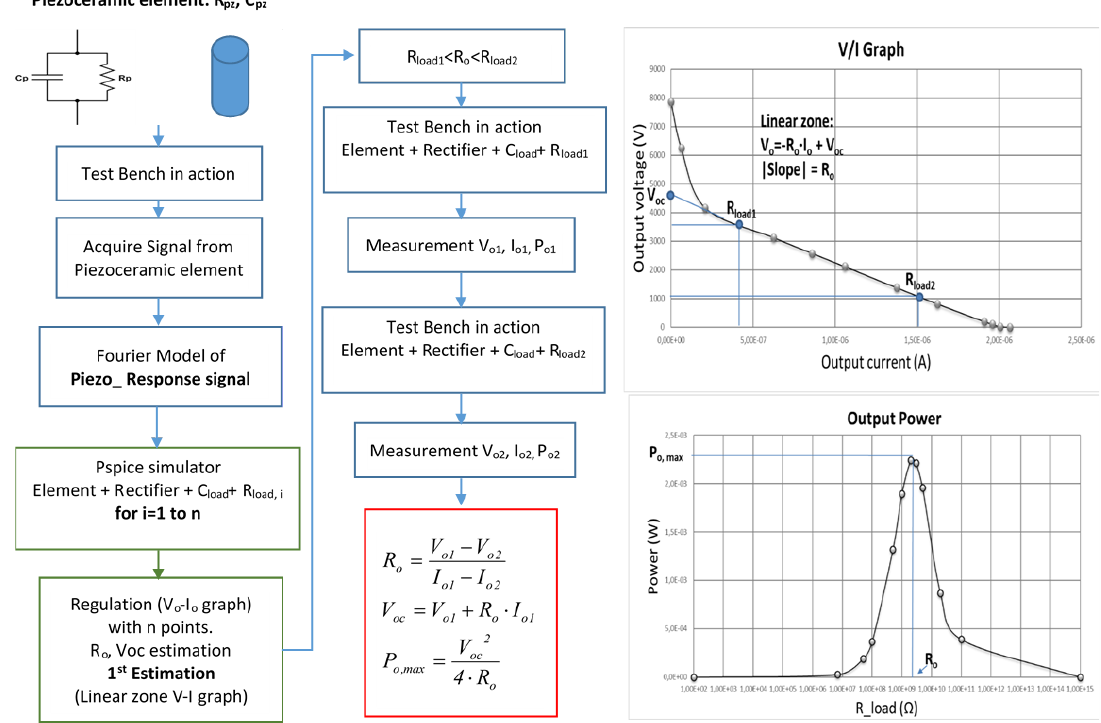
Figure 4. Methodology applied in the original piezoelectric characterization system.